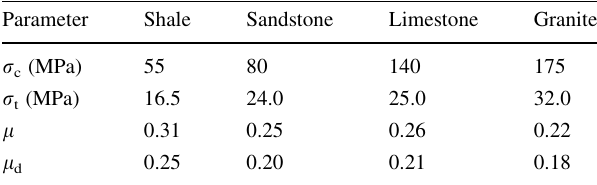
Parameter Shale Sandstone Limestone